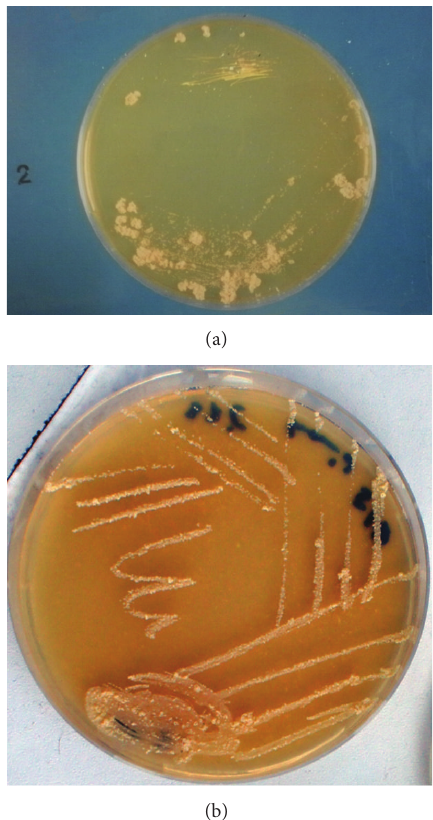
Figure 2: Growth of Mycobacterium farcinogenes on glucose yeast extract agar (a) and M. senegalense on glucose yeast extract malt extract agar (b) at 37 ∘ C for 7 days, showing nonchromogenic, wheat- colored rough convoluted irregular